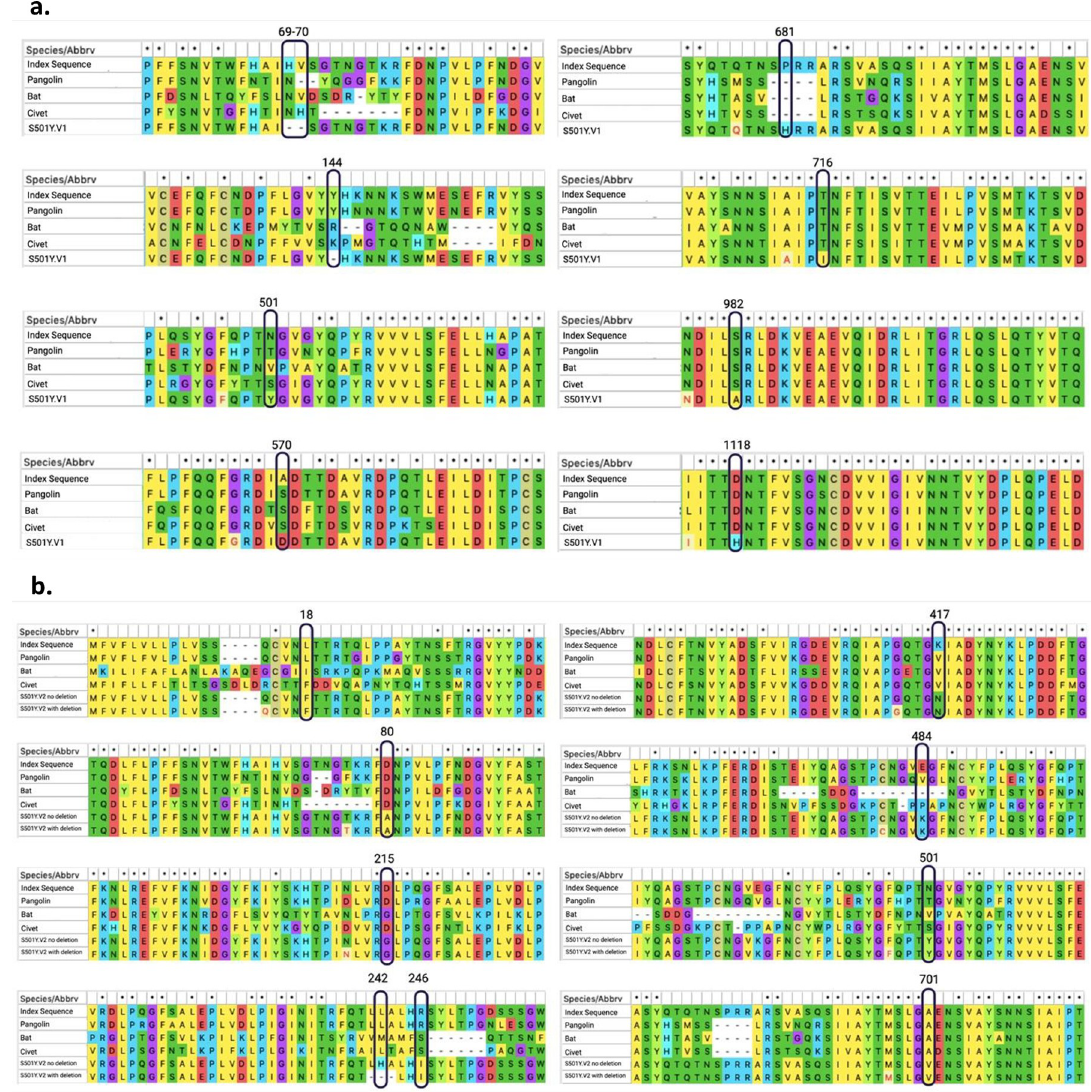
Fig 4. Sequence alignment of the spike protein of the SARS-CoV-2 variants. (a) Conservation of mutations found in 501Y.V1 in comparison to the Wuhan index human, bat, civet and pangolin spike protein sequences. (b) Conservation of mutations found in 501Y. V2 in comparison to the index Wuhan human, bat, civet and pangolin spike protein sequences. Sequence alignments generated using MEGA X software.